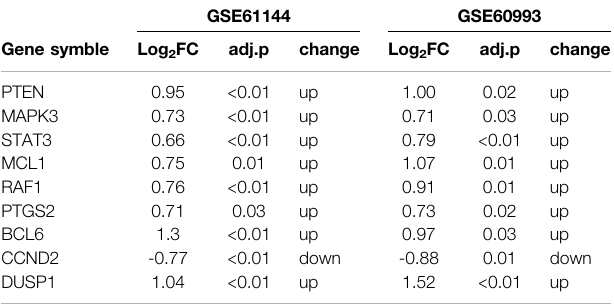
TABLE 2 | Difference analysis results of 9 hub genes in dataset